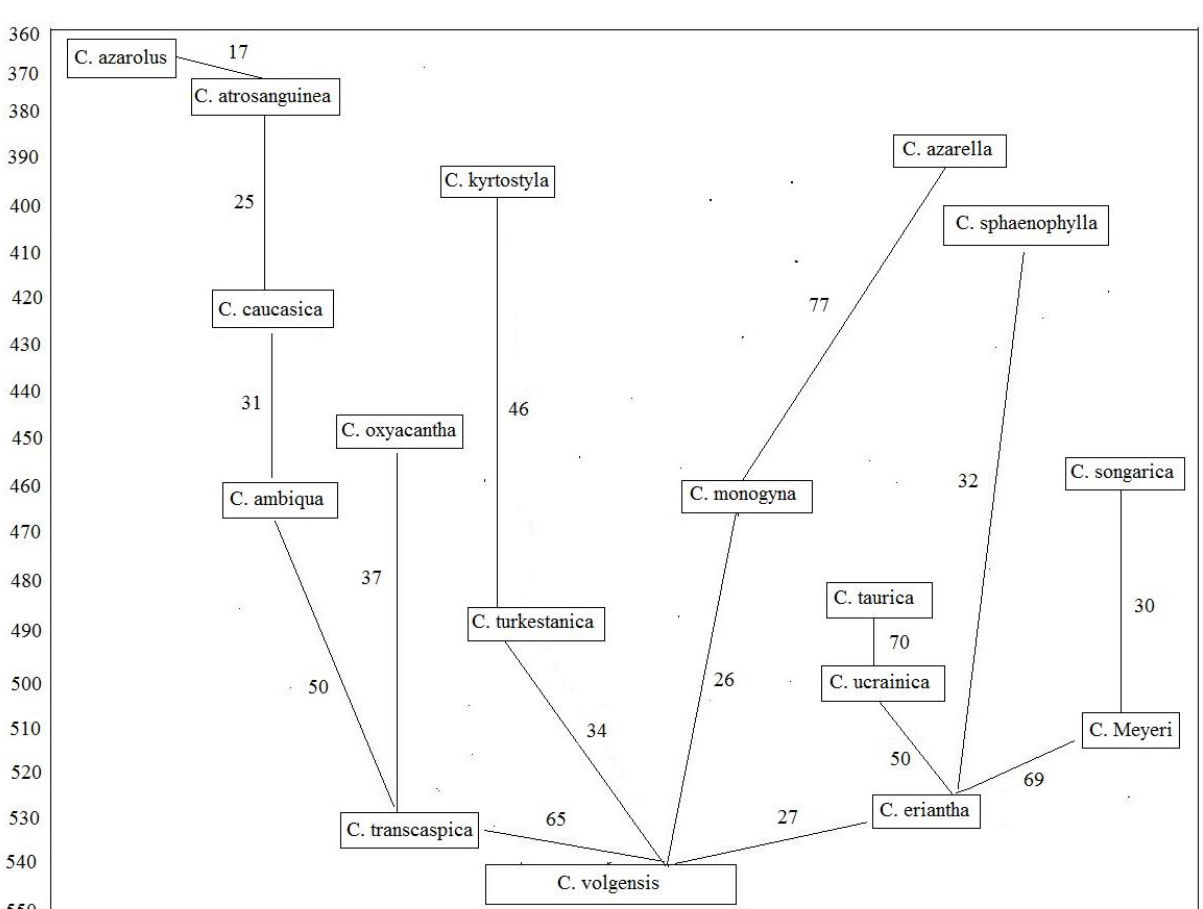
Fig. 2. Dendrogram of taxonomic distances of hawthorn species in the Oxyacanthae Zbl. section by vegetative